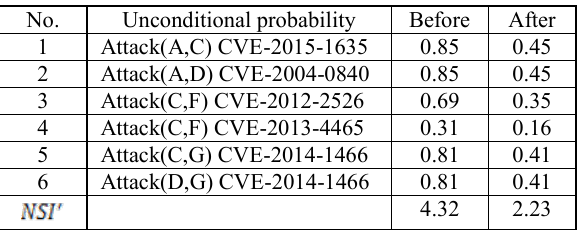
Table 2. The unconditional probability of each atom